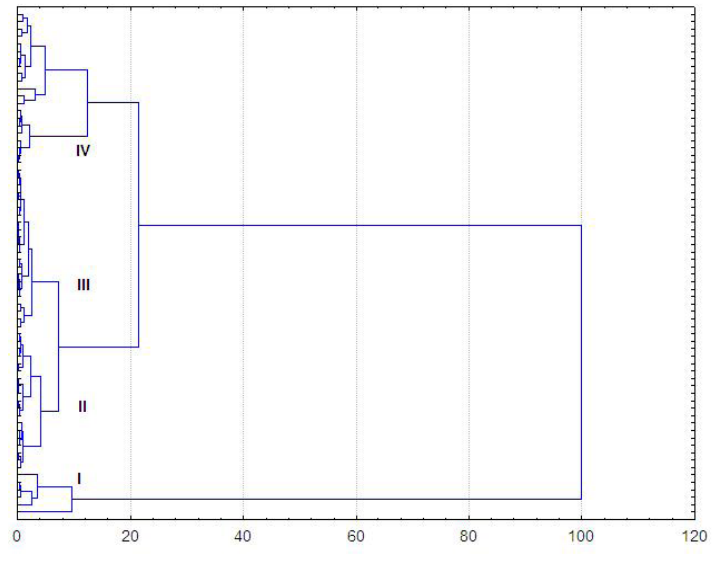
Figure 3: Dendrogram of the studied herbal infusions.